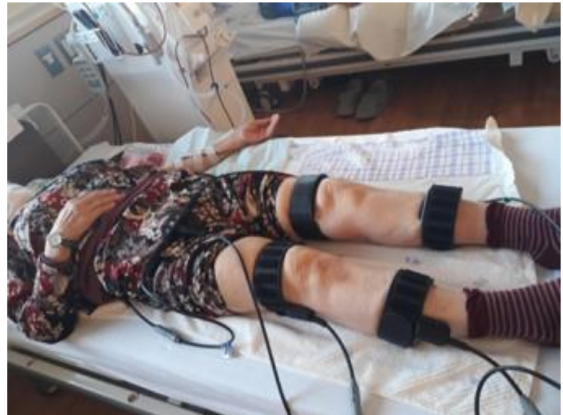
Figure 2. Application of the belt electrode-skeletal muscle electrical stimulation intervention. Patients were placed in the supine position. Five silicon–rubber electrode bands were applied to the patient’s waist and bilateral thighs and ankles. Electrical muscle stimulation was administered for 40 min per